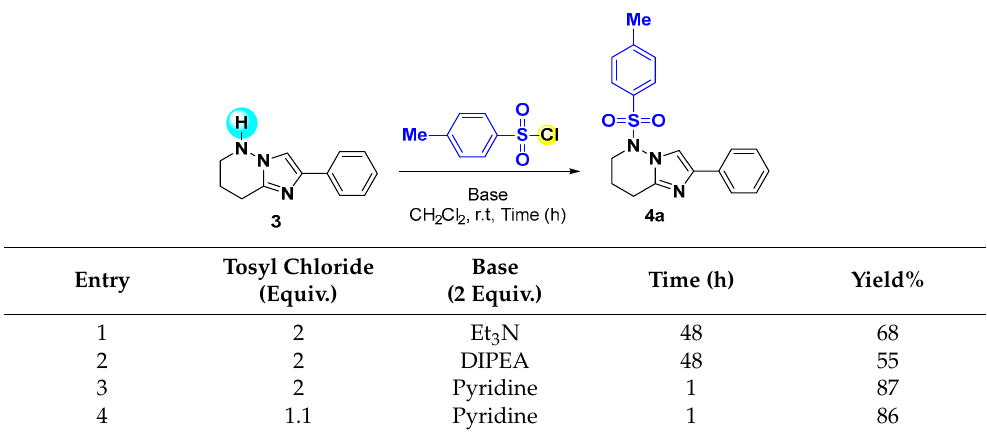
Table 1. Optimization of the conditions of the sulfonylation reaction.